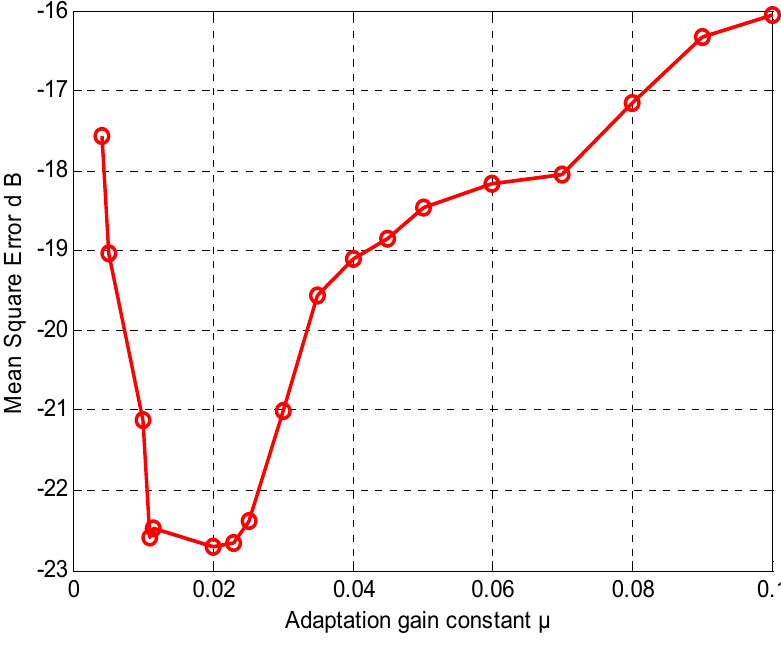
Figure 9. Deducing the best value for step-size gain factor μ